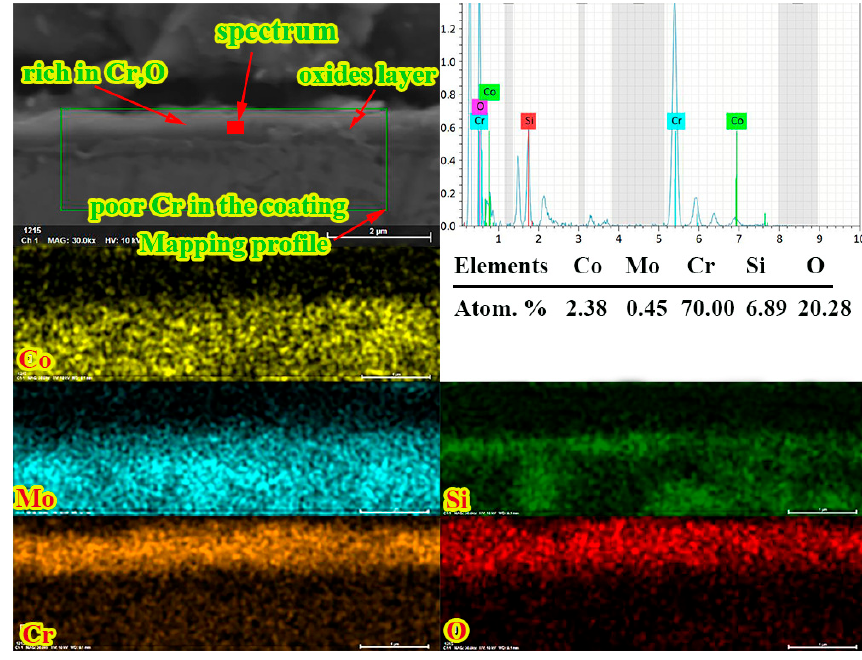
Figure 11. The cross-sectional images of oxides layer of CoMoCrSi coatings annealed for 3 h ( a ), 5 h ( b ), and 10 h ( c ).